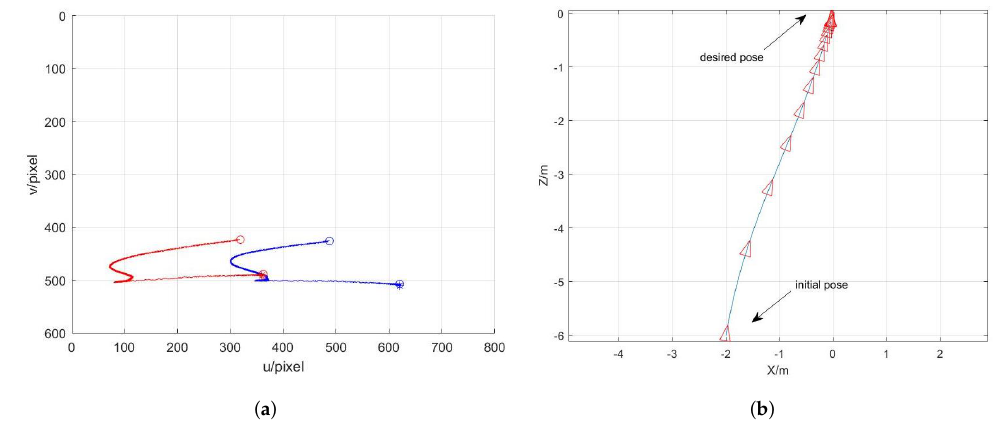
Figure 4. Simulation of the initial poseture X 0 = [ − 2, − 6,10 ◦ ] T .